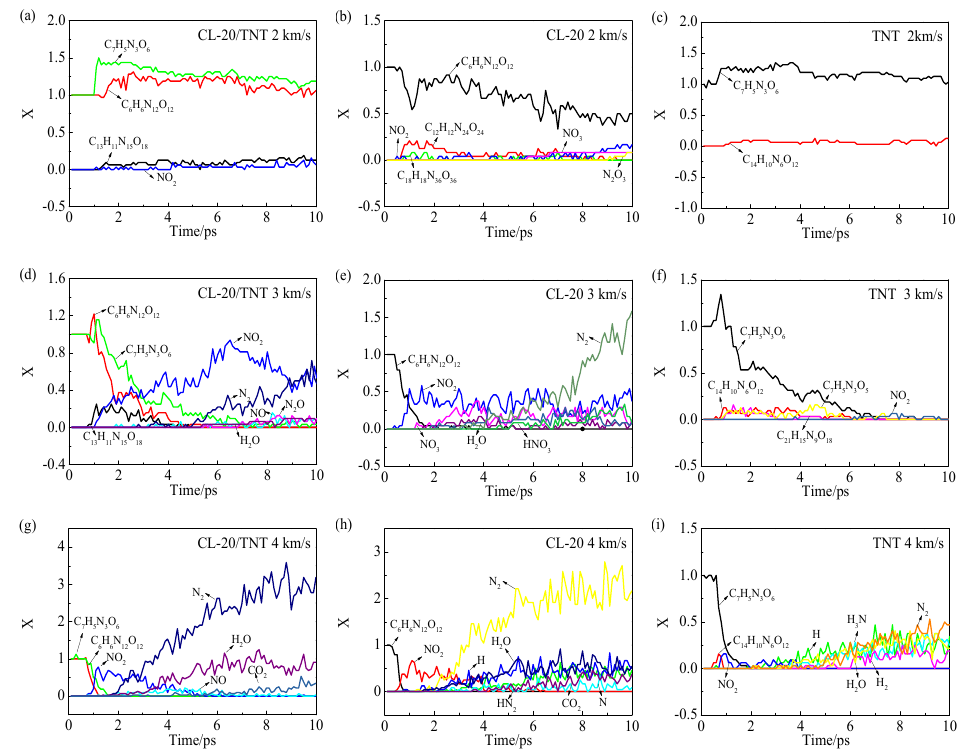
Figure 4. Time-dependent curves of the X values of the different substances in the CL-20/TNT, CL-20 and TNT crystals at impact velocities of ( a – c ) 2 km/s, ( d – f ) 3 km/s and ( g – i ) 4 km/s. In terms of the species, the main products in the CL-20/TNT cocrystal at different impact velocities were NO 2 , N 2 , NO, H 2 O, N 2 O and CO 2 . For the CL-20 crystal, the main products were NO 2 , NO 3 , H 2 O, HNO 3 , N 2 , HN 2 and CO 2 . For the TNT crystal, C 7 H 5 N 3 O